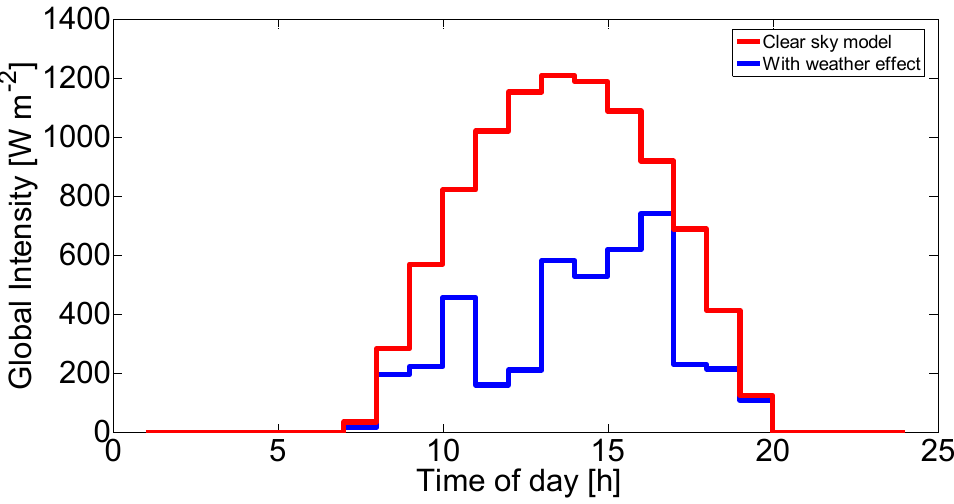
Figure 4. Global solar radiation in hour resolution with the weather effect generated using the MTM technique and the envelop curves without the weather effect.